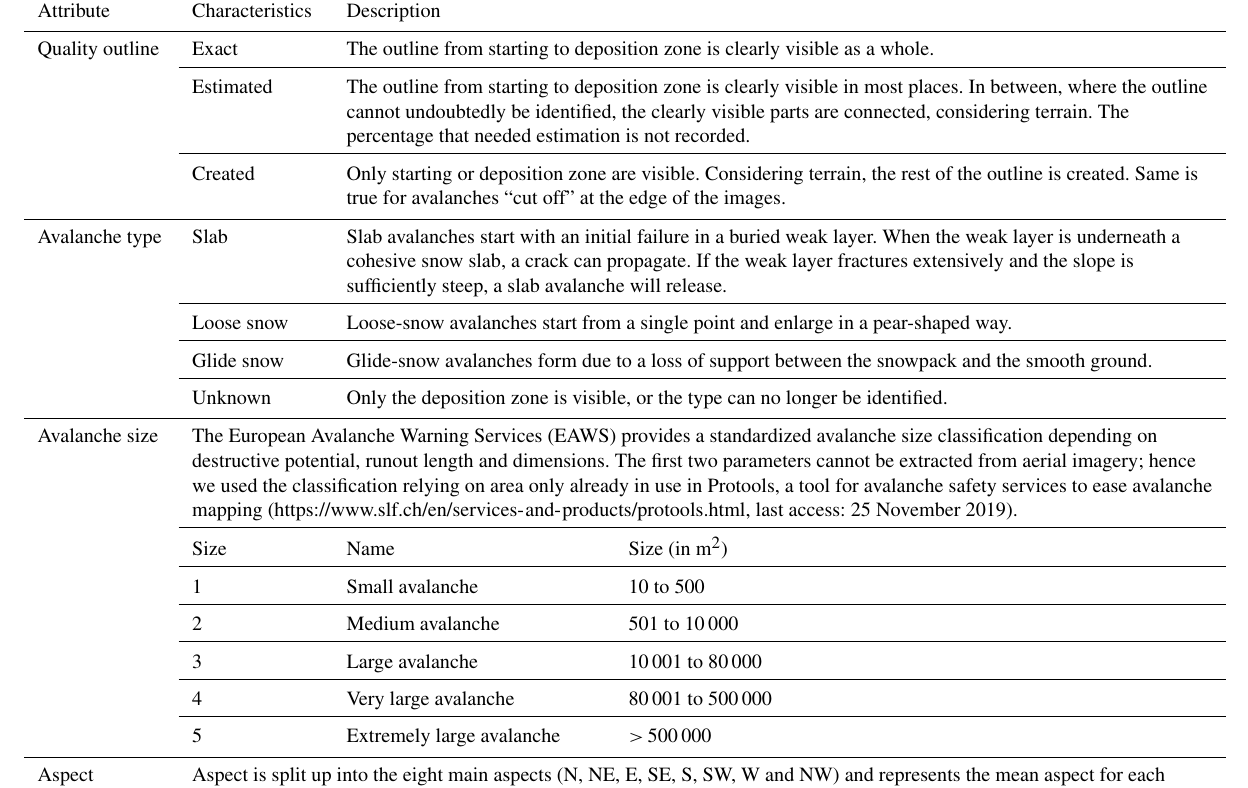
Table 2. Description of avalanche attributes. Attribute Characteristics Quality outline